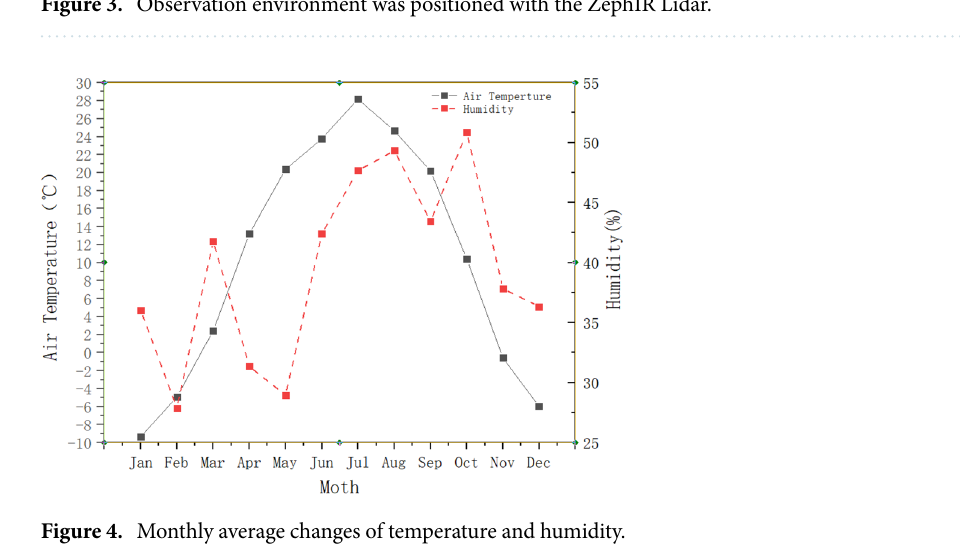
Figure 3. Observation environment was positioned with the ZephIR Lidar.